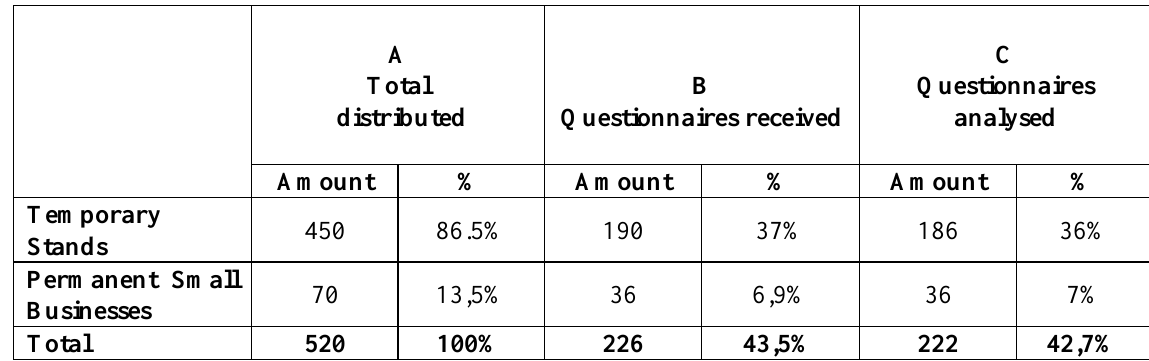
Table 1: Questionnaires distributed, completed and